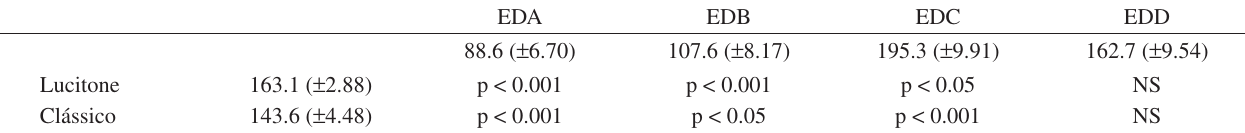
Table 2. Impact resistance (J.m –1 ). Comparison of commercial materials and injected experimental materials (1-way ANOVA and Bonferroni’s test - p < 0.05).